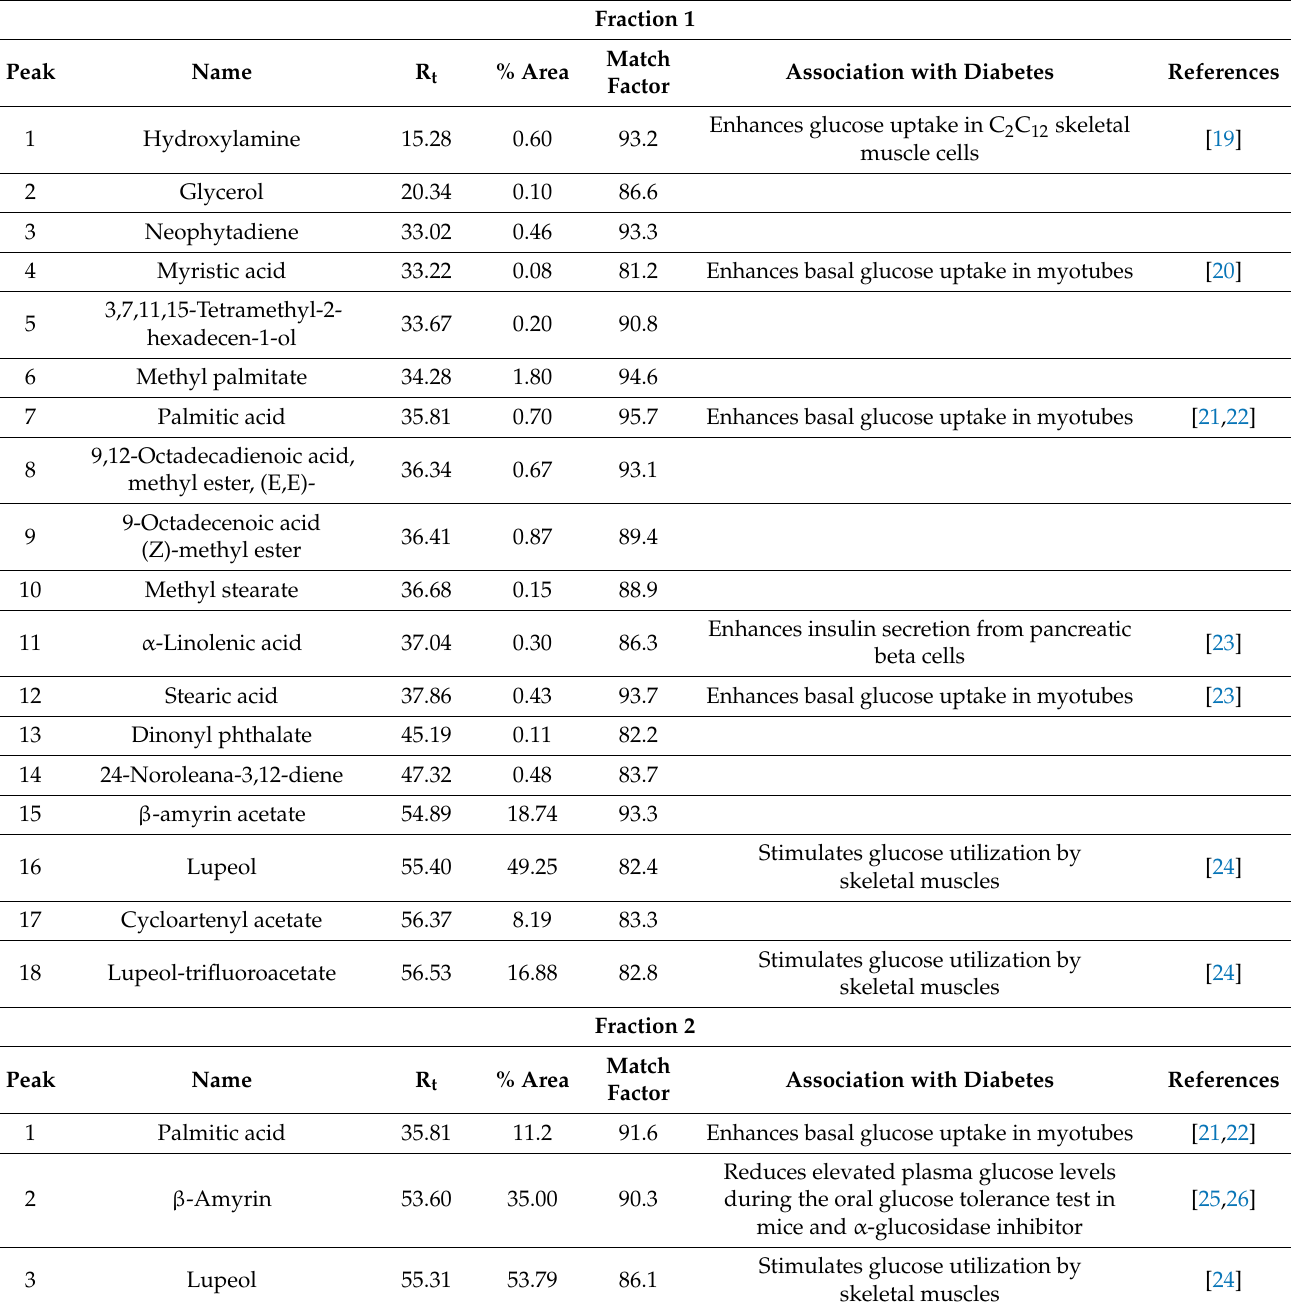
Table 2. Phytochemicals of Gundelia tournefortii methanol extract fractions verified by gas chromatography–mass spectrometry.